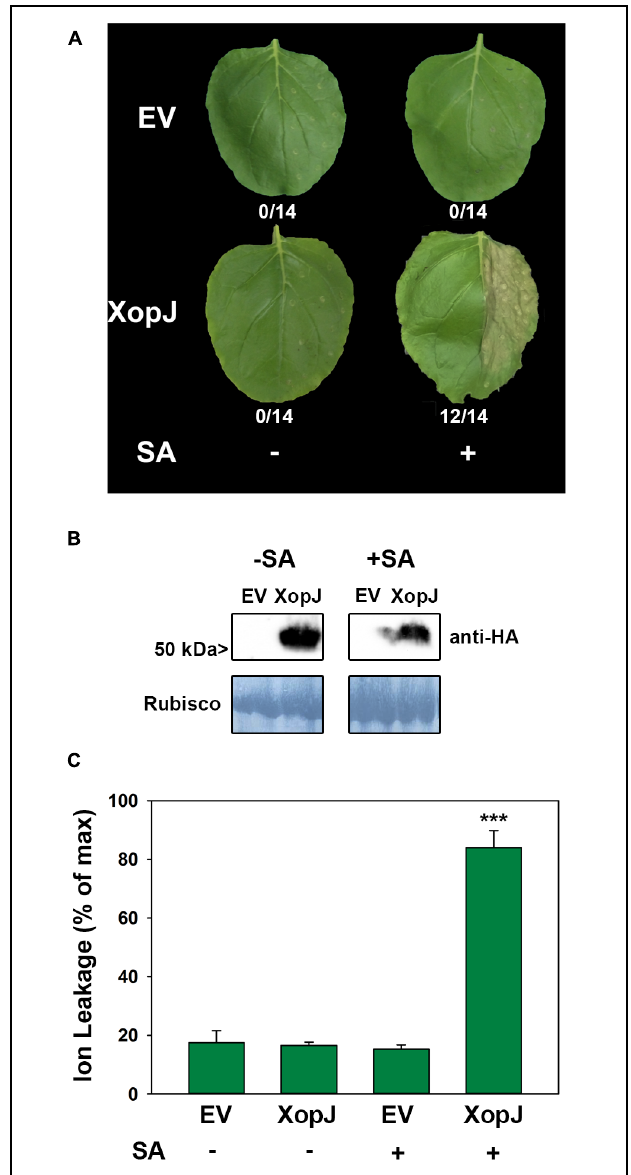
FIGURE 1 | Salicylic acid (SA) treatment of Nicotiana benthamiana leaves transiently expressing XopJ elicits a hypersensitive response (HR)-like response. (A) Phenotype of N. benthamiana leaves (one half) infiltrated with Agrobacterium tumefaciens strains that mediate T-DNA-based transfer of XopJ-HA and empty vector (EV). Leaves were sprayed with 5 mM salicylic acid (or water) 24 h post infiltration (hpi) and leaves were photographed 48 hpi. The number of leaves showing HR-like symptoms from all leaves analyzed is indicated below the appropriate construct. (B) Protein extracts from N. benthamiana leaves transiently expressing XopJ-HA or EV at 48 hpi were prepared. Equal volumes representing approximately equal protein amounts of each extract were immunoblotted and proteins were detected using anti-HA antiserum. Amido black staining served as a loading control. (C) Ion leakage was measured in plants transiently expressing XopJ-HA and EV at 48 hpi ( ± SA treatment). Bars represent the average ion leakage measured for triplicates of six leaf disks each, and the error bars indicate SD. The asterisk indicates a significant difference ( ∗∗∗ P < 0.001) based on results of a Student’s t -test. The experiment has been repeated three times with similar